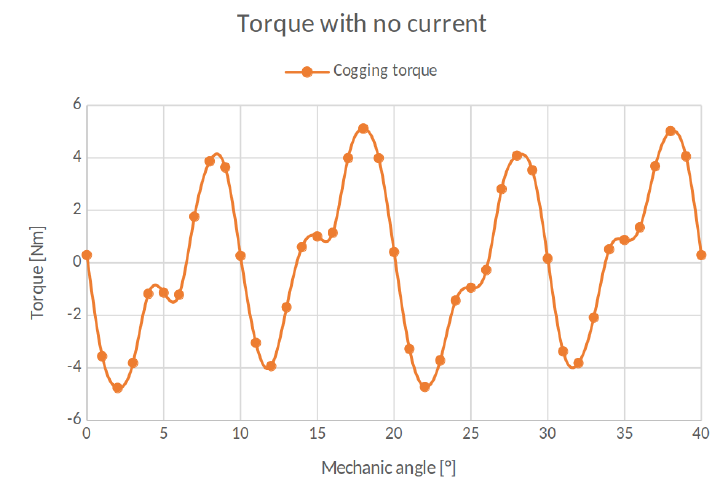
Figure 14. Cogging torque obtained from a FEM simulation of an axial-gap TFM.